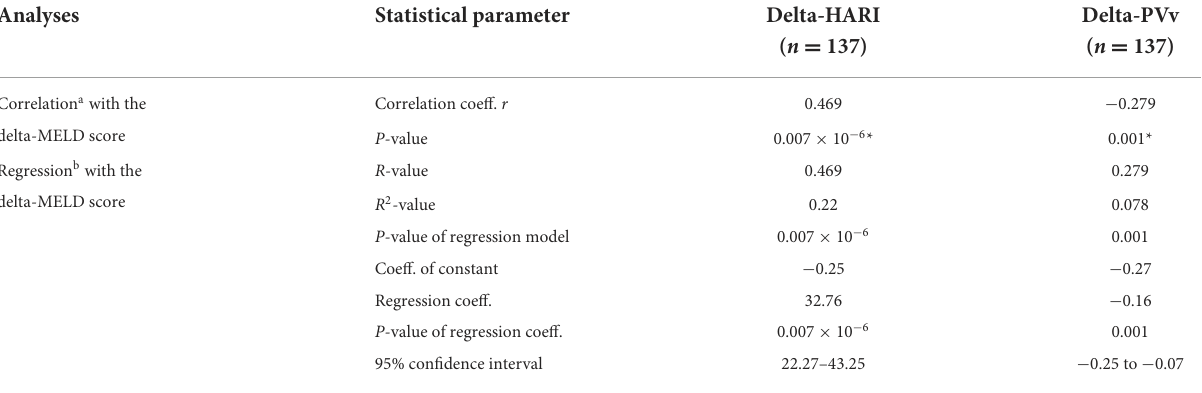
TABLE 2 Correlation and regression analyses between perfusion parameters and delta-MELD score.